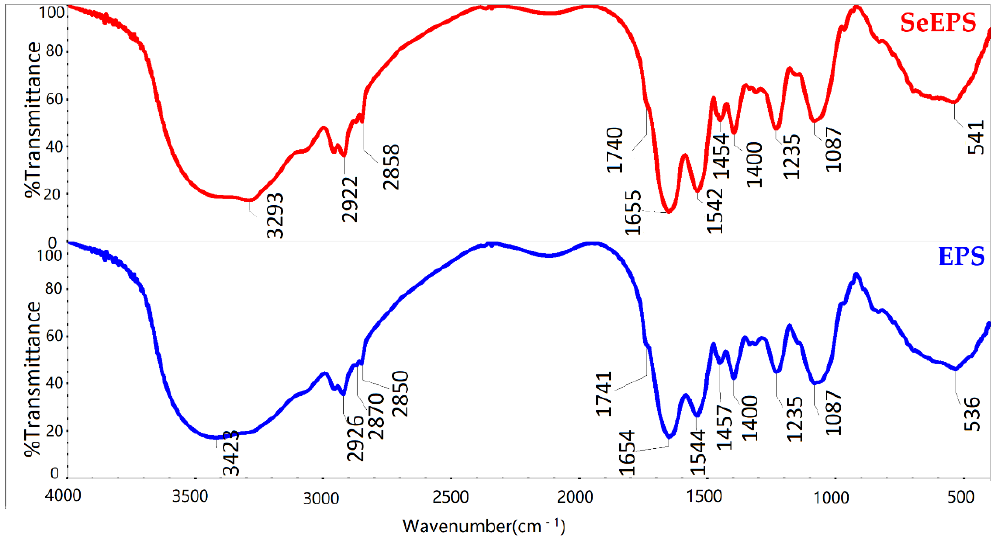
Figure 2. FTIR spectrum of SeEPS and EPS.